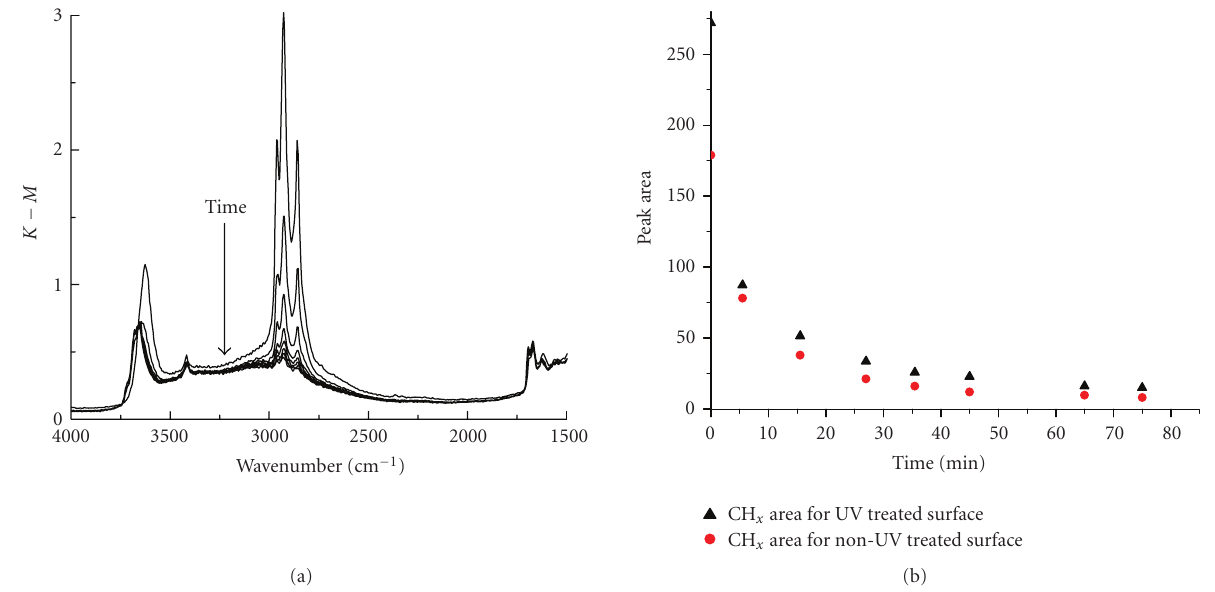
Figure 4: Typical time series of decane desorption on TiO 2 in vacuo (a), and hydrocarbon peak intensity of decane absorbed to UV versus non-UV-treated TiO 2 (b).